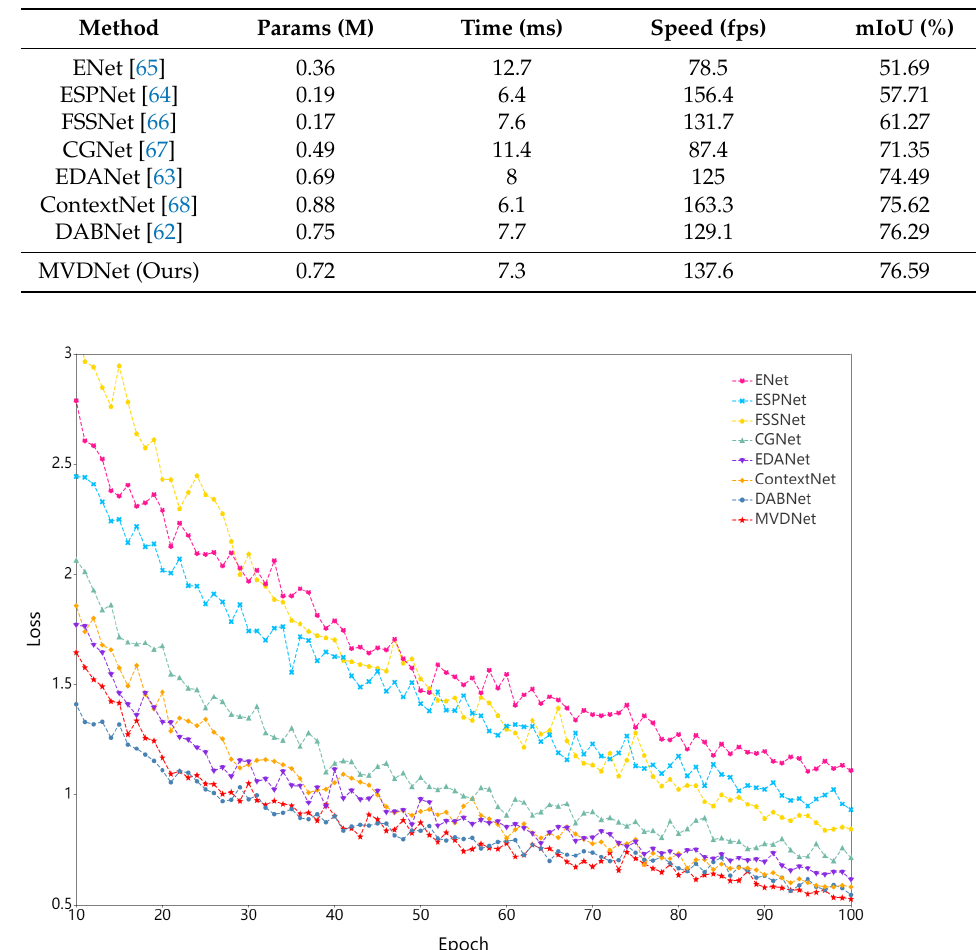
Figure 6. Training loss curve. Table 8. Speed and accuracy comparison of MVDNet on the MVD test